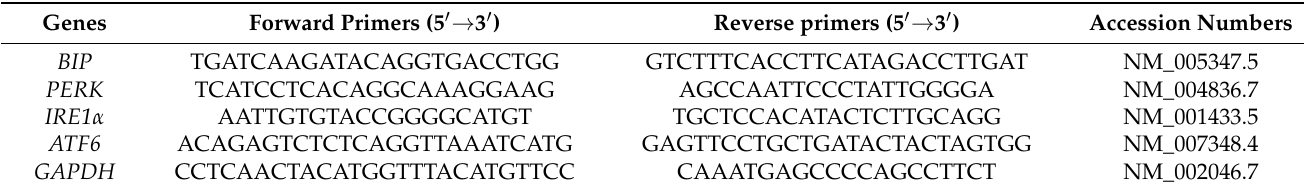
Table 1. Primers of ER-stress-related